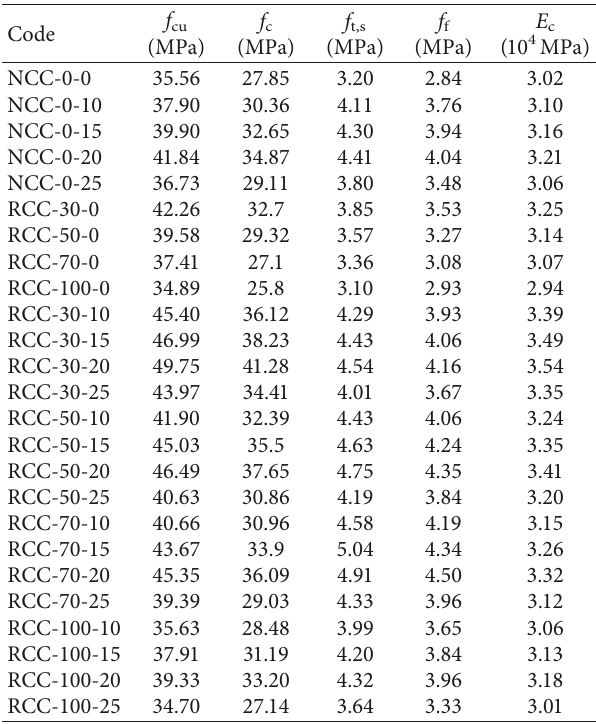
Table 4: Test data.